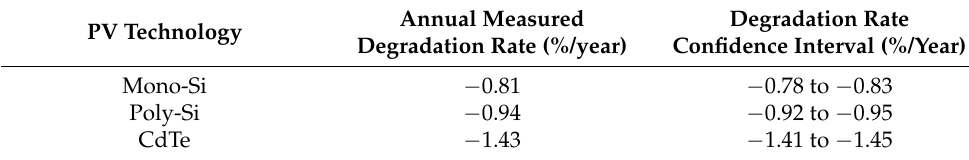
Table 2. Summary of the annual degradation rate per PV technology